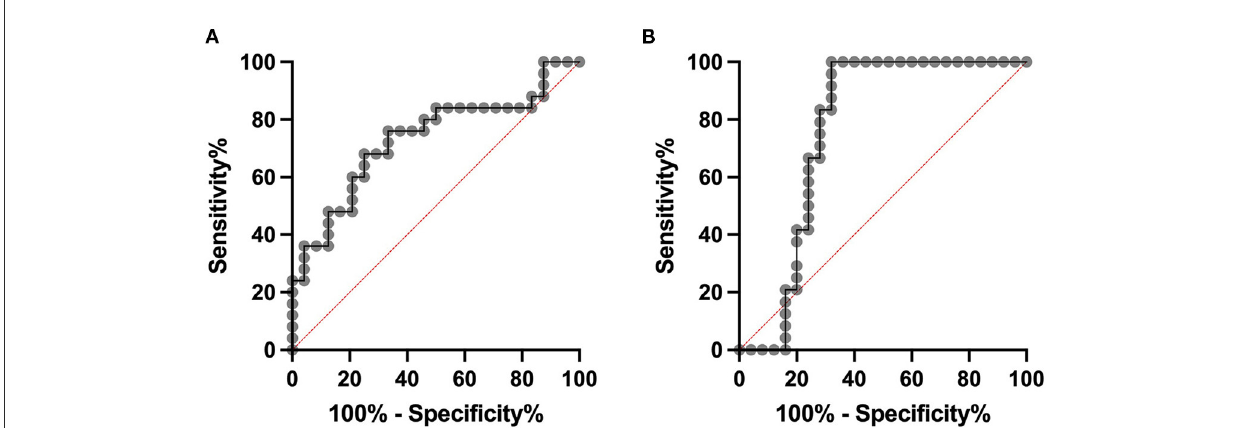
FIGURE3 ROC analyses. Cows with subclinical mastitis can be distinguished from healthy controls with a sensitivity of 0.76 and a specificity of 0.62 at a cut-off of 122.4 pg/mL in serum (A) . The area under the curve is 0.73. In milk at a cut-off of 89.9 pg/mL sensitivity of 0.83 and a specificity of 0.72 was calculated. The area under the curve is 0.76 (B)